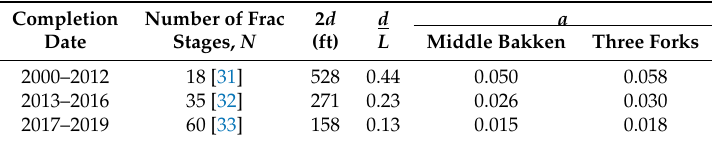
Table A2. Reservoir properties used in scaling oil production in the Middle Bakken and Three Forks